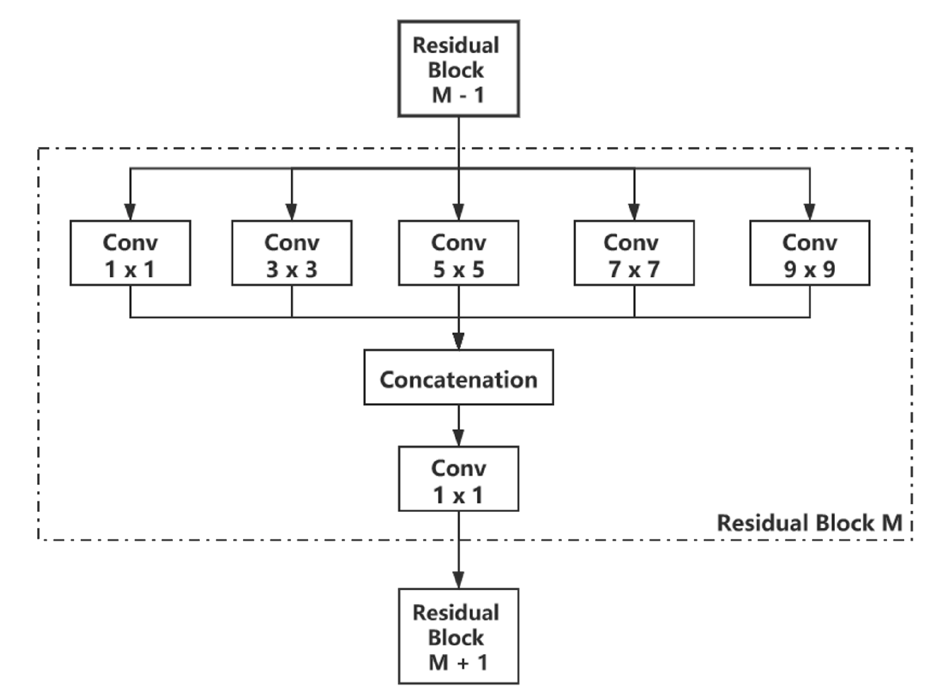
Figure 2. Architecture of a multicore multiscale residual block (MCMSRB).